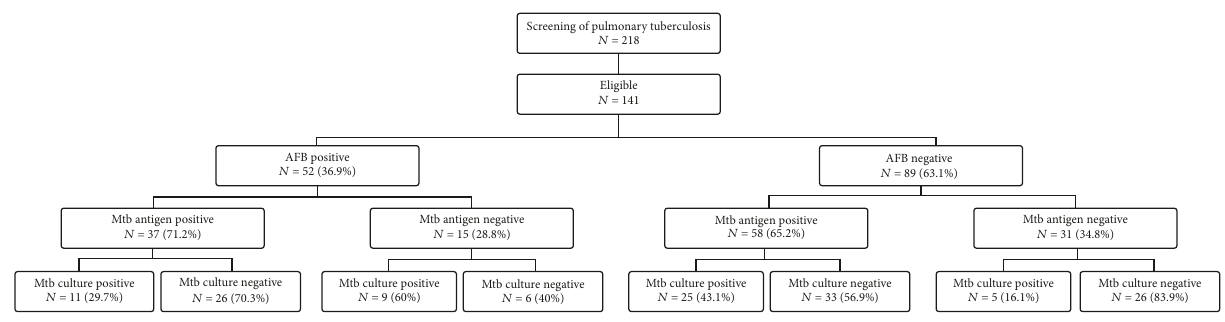
Figure 1: The pulmonary tuberculosis patient diagnostic